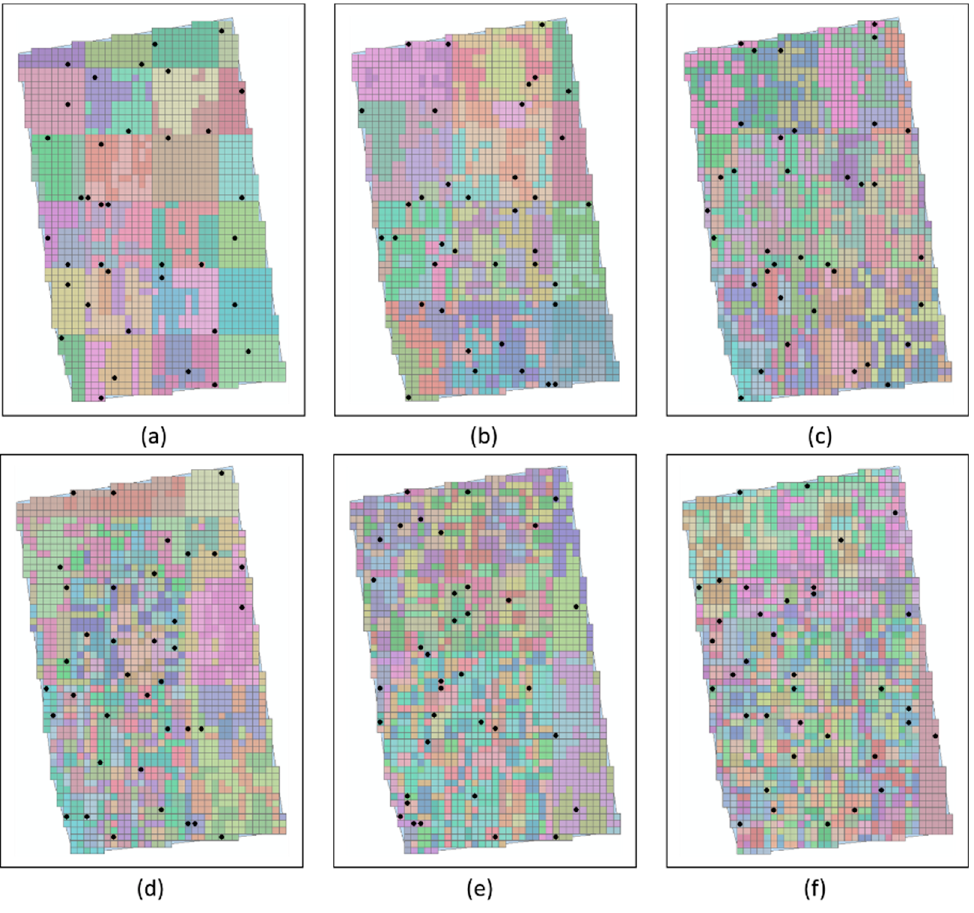
Figure 4. The clustering results based on the crop yields that were produced using the WOFOST model and the distribution of the sampling points in the tested field that were produced by the different sized super-grids: ( a ) 200 × 200 m 2 , ( b ) 300 × 300 m 2 , ( c ) 400 × 400 m 2 , ( d ) 500 × 500 m 2 , ( e ) 600 × 600 m 2 , and ( f ) 700 × 700 m 2 .